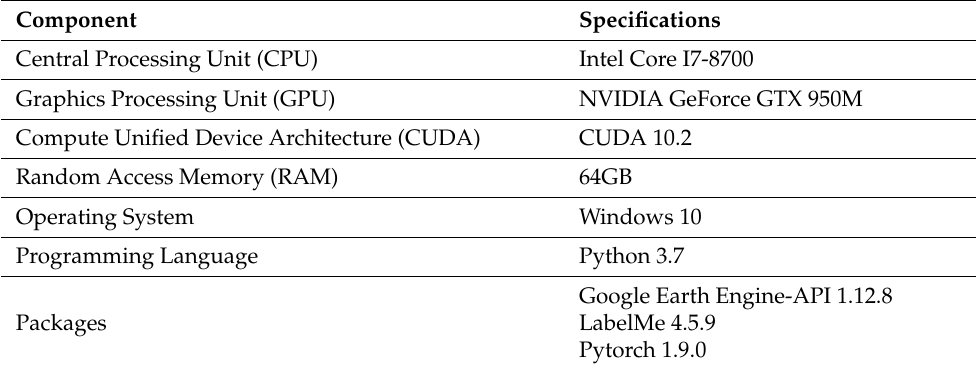
Table 1. Experimental environment.